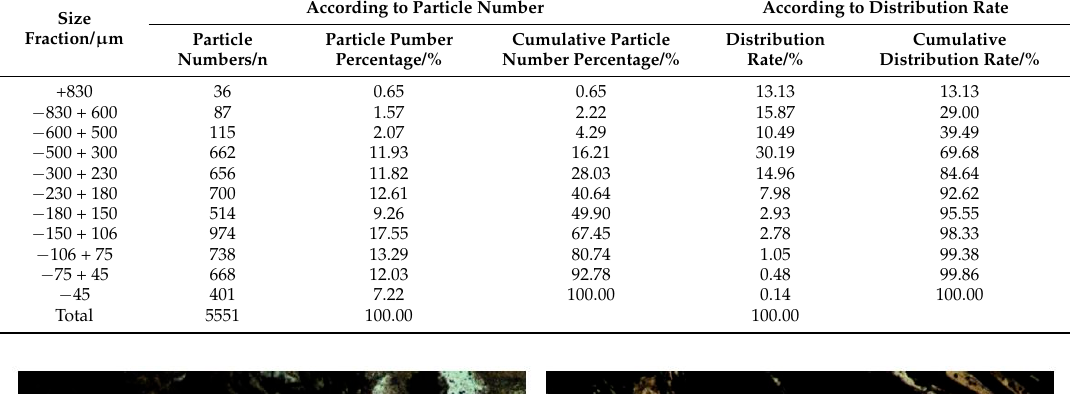
Table 4. Liberation characteristics of the graphite flakes.